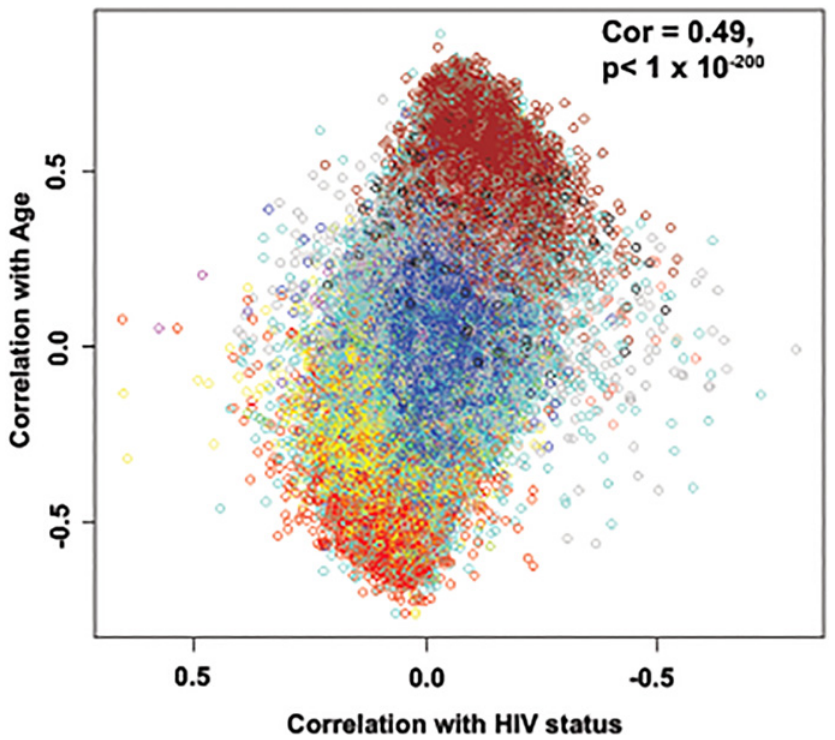
Fig 1. Age effects versus HIV-1 effects on methylation status. Methylation differences for each of the 24 pairs of samples were calculated and a paired t-test was performed for each of the CpG sites on the 450K array. The HIV-1 effect (X-axis) was measured as the signed logarithm of the Student t-test p-value. Age effects (Y-axis) were measured by the Pearson correlation coefficient with age. Each dot is colored according to its module membership (See Fig. 2). This is a representative figure for both data